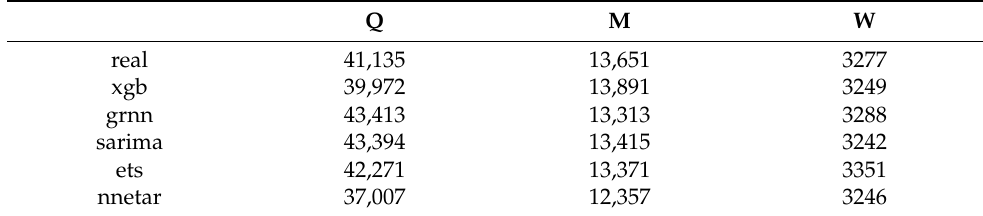
Table 4. Sums of energy consumption-real vs. forecasts (in